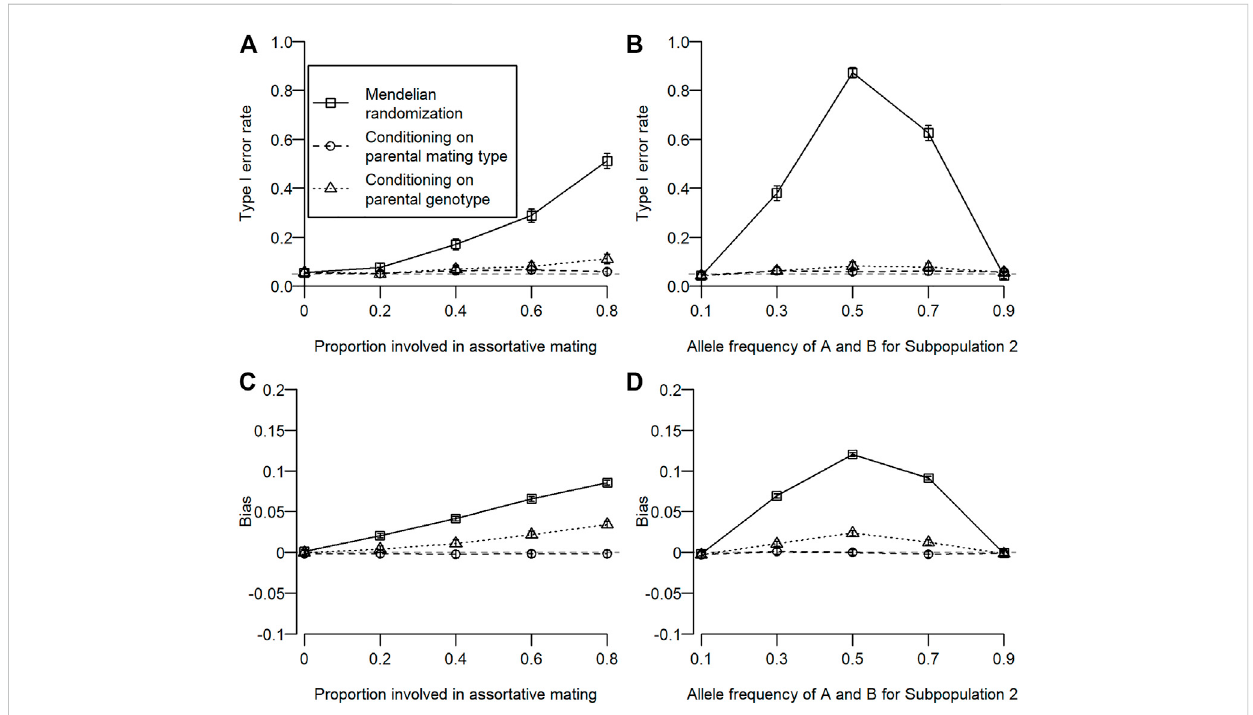
FIGURE 2 Type I error rate and bias of estimated coef fi cients for three different types of MR. Open squares, open circles, and open triangles correspond to conventionalMR,MRconditioningonparentalmatingtypes,andMRconditioningonparentalgenotypes,respectively.Forsimulation1,theproportionof the population involved in assortative mating was changed from 0 to 0.8. For simulation 2, allele frequencies of A and B for subpopulation 2 were varied from 10% to 90%. ( A, B) Type I error rates for simulations 1 and 2. Gray dotted lines are signi fi cance levels (= 0.05). ( C, D) Bias in the